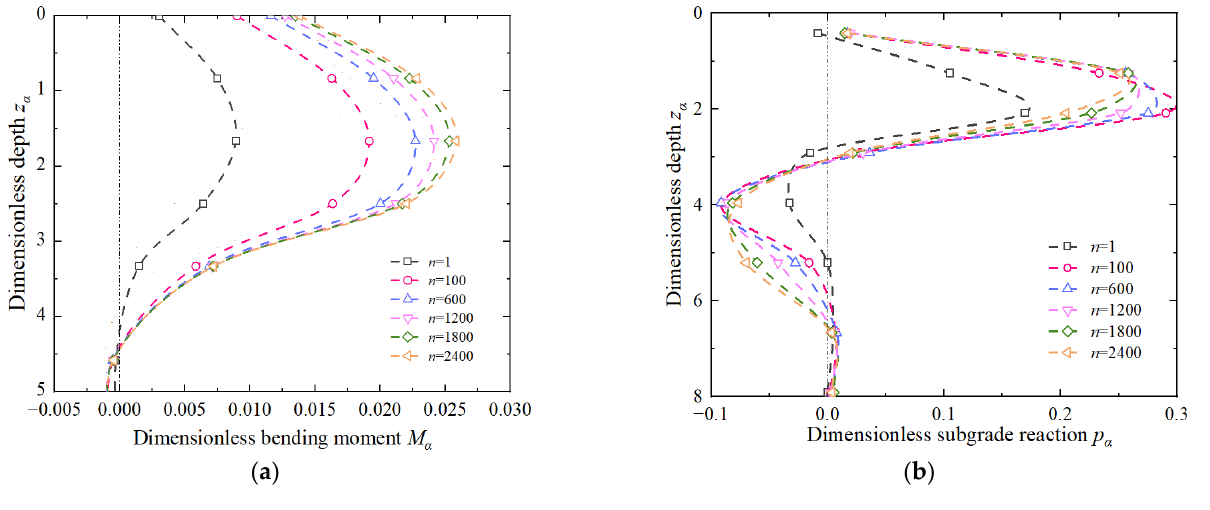
Figure 14. Dimensionless bending moment and subgrade reaction profiles under different slope angles and load amplitudes. ( a ) bending moment profiles; ( b ) subgrade reaction profiles.